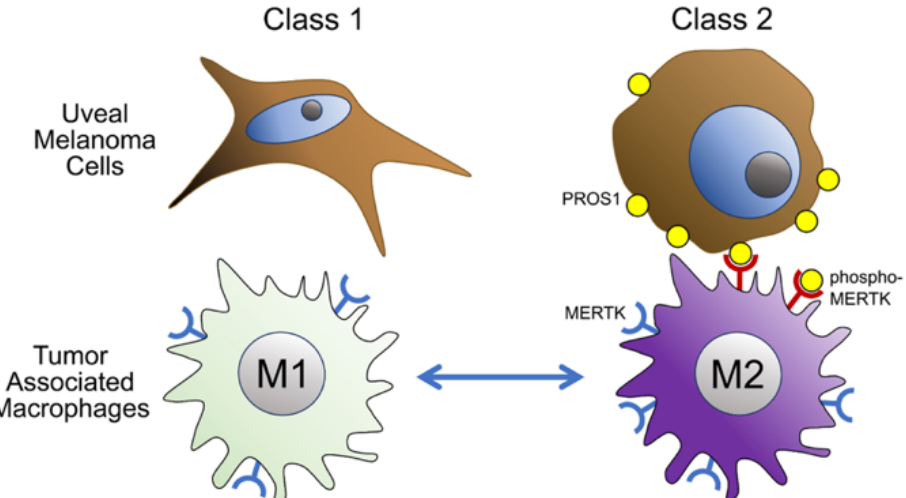
Figure 5. Proposed model for how BAP1 loss leads to suppression of the tumor immune microen- vironment. In class 1 BAP1-wildtype uveal melanomas, tumor cells express low levels of PROS1, and tumor-associated macrophages are mostly M1-polarized with low MERTK expression and low MERTK phosphorylation. In BAP1-mutant class 2 uveal melanomas, PROS1 is upregulated since it is no longer repressed by BAP1. Mostly, membrane-bound PROS1 on tumor cells interacts with MERTK on nearby macrophages, leading to phosphorylation of MERTK and activation of downstream signaling that promotes M2 polarization.